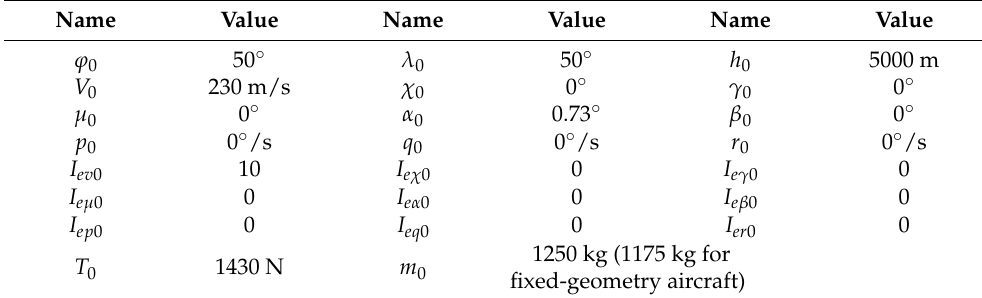
Table 3. Initial state settings of the morphing aircraft and the integrators in Section 5.1.